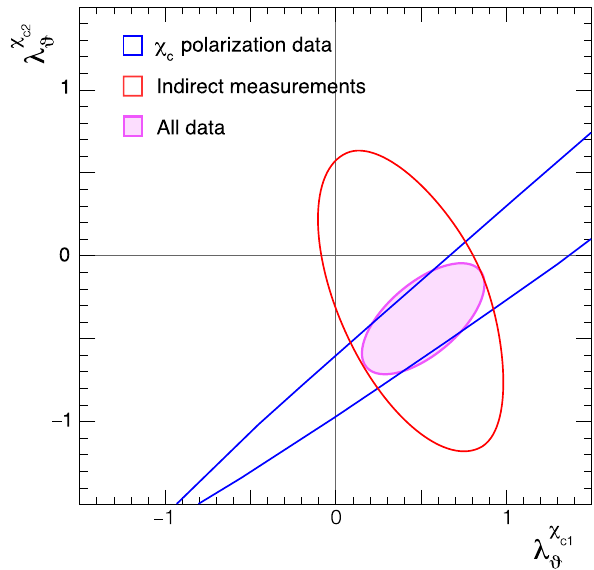
Fig. 9 Two-dimensionaldistributionsshowingthecorrelationbetween χ c 1 λ χ c 2 the λ ϑ ( ϑ ) observable and the the prompt J /ψ production rate. The results of the three fit variants are represented by the solid (4 β ), dashed (1 β ) and dotted-dashed (6 β ) lines